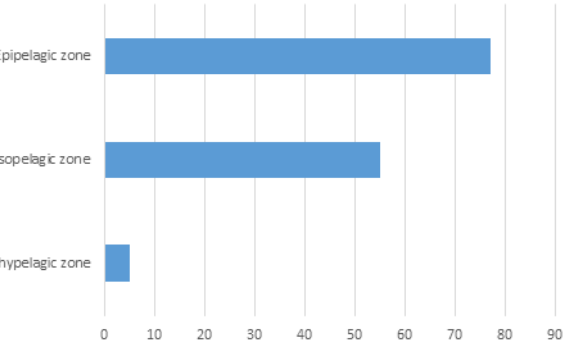
Figure 6. Number of fish species in each depth zone of the Adriatic Sea pelagic environment.